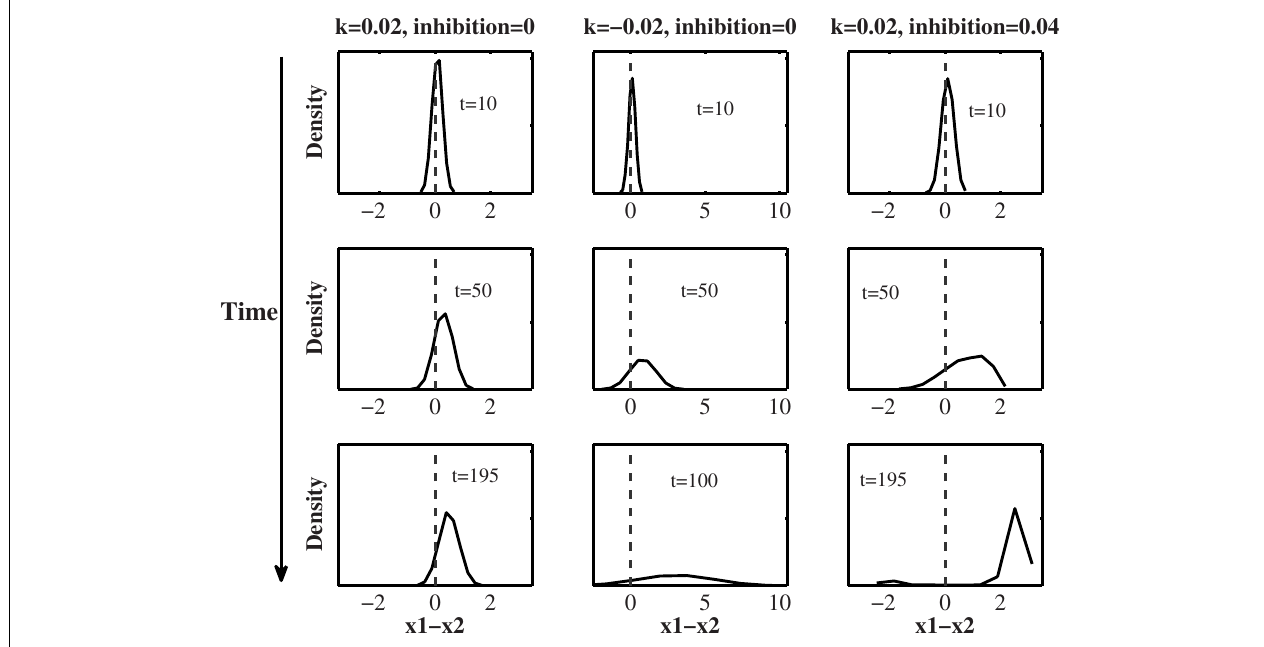
FIGURE 3 |Time evolution of the decision variable x = x 1 − x 2 in three different leak-inhibition conditions. Adapted with permission from Usher and McClelland (2001).